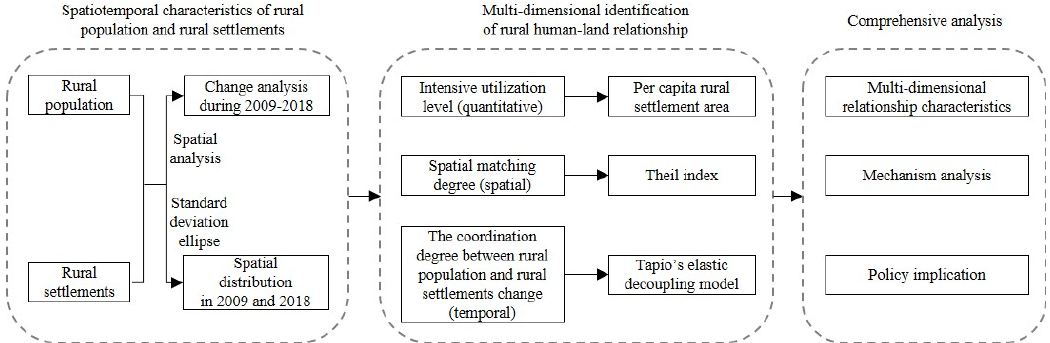
Figure 2. Research framework and methodology used in this study.